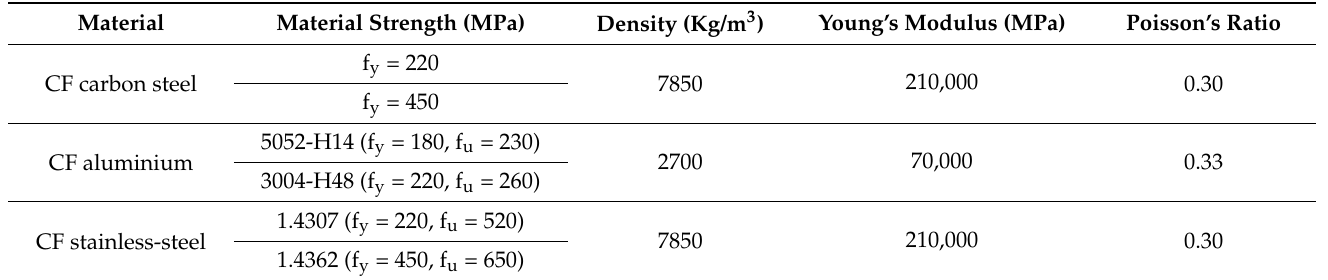
Table 2. Selected material properties for the parametric study.